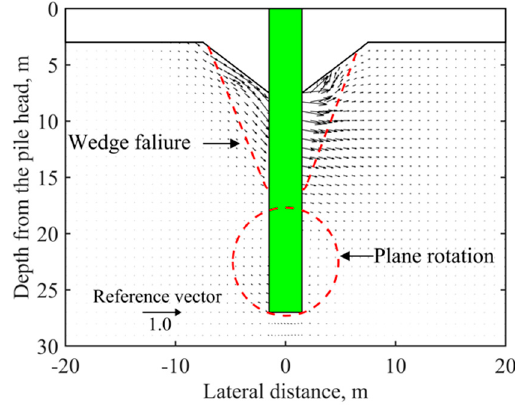
Figure 10. P Lin and k Lin values calculated from the Lin’s analytical model: ( a ) Ultimate soil resistance, ( b ) Initial stiffness.